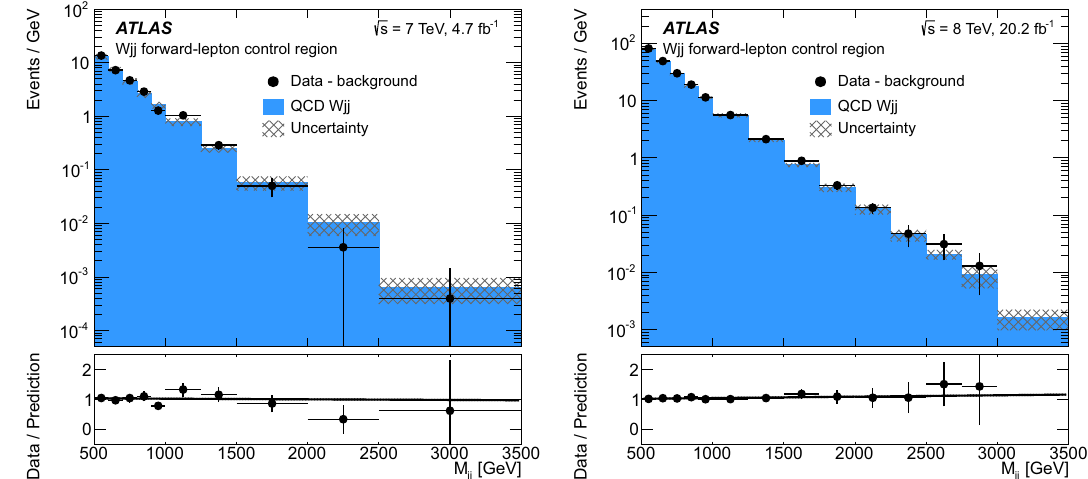
Fig. 7 Comparison of the predicted QCD W jj dijet mass distribution to data with background processes subtracted, for events in the forward- lepton control region in 7 TeV ( left ) and 8 TeV ( right ) data. The bottom